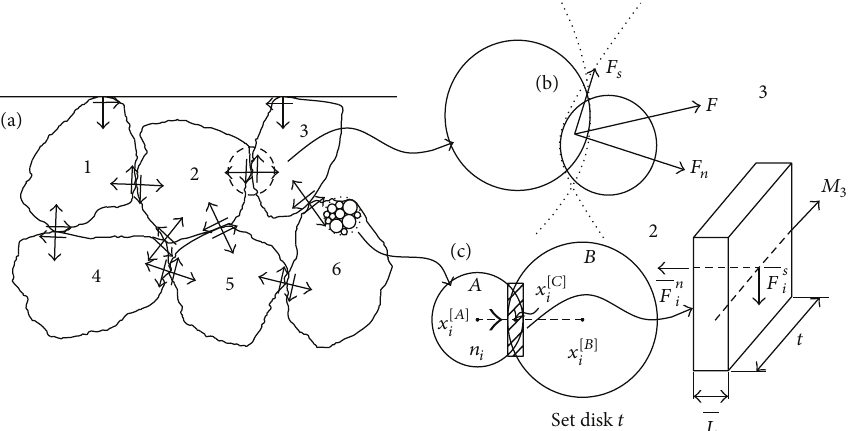
Figure 1: The contact constitutive models of spoils: (a) the compression test model; (b) the unbonded model; (c) the parallel bonded model.